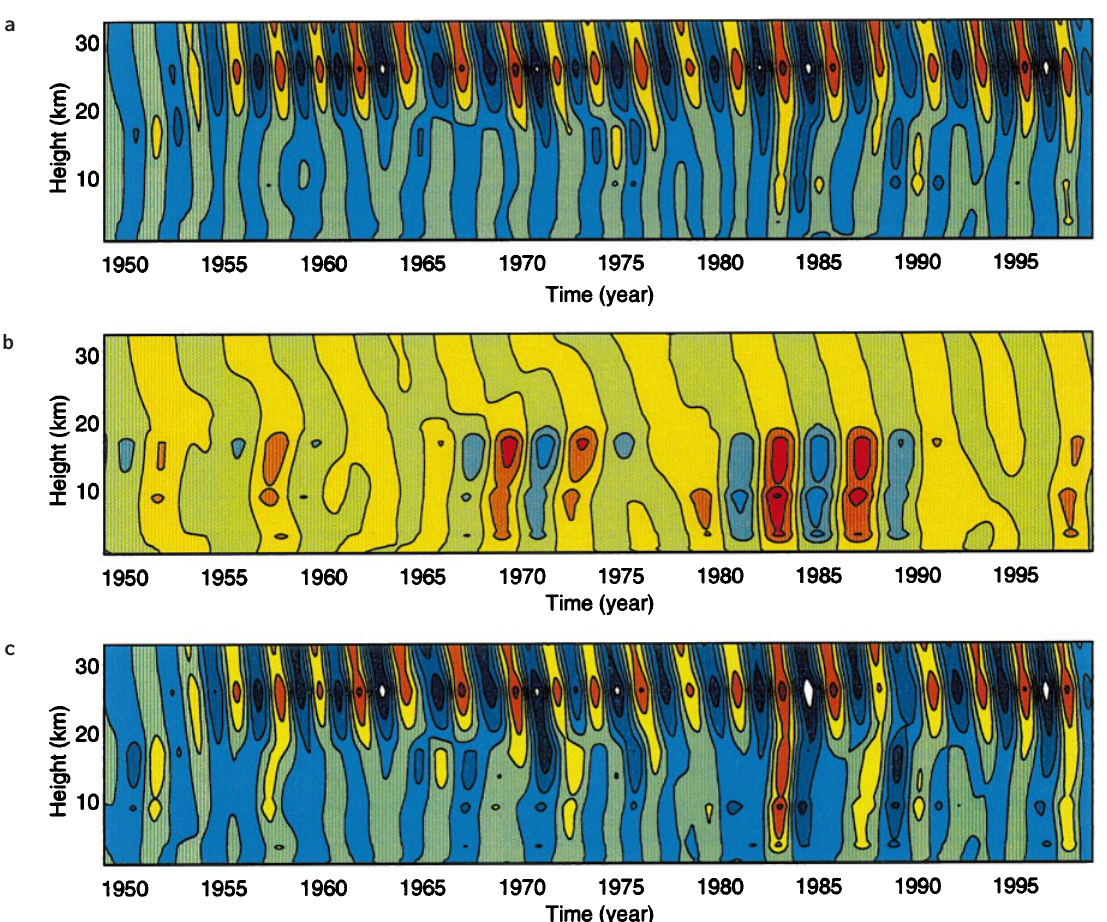
contributions from blue to deep blue , with contour at 0.01 ms intervals. For b , positive contributions are coloured from orange to red , negative contributions from light green to light blue , at 0.005